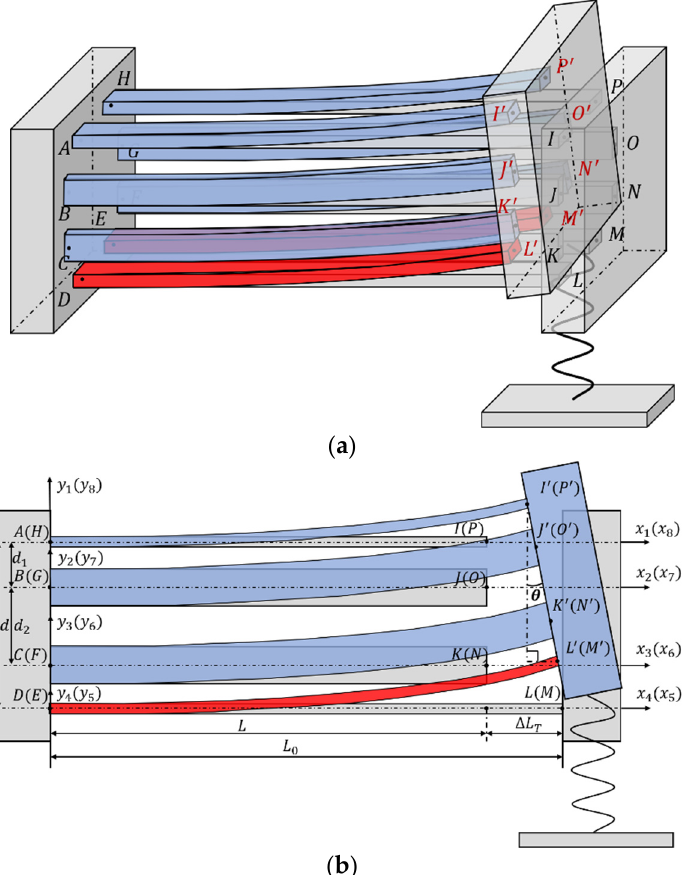
Figure 4. Structure analysis of the 3D U-shaped actuator. ( a ) the general view; ( b ) the front view.